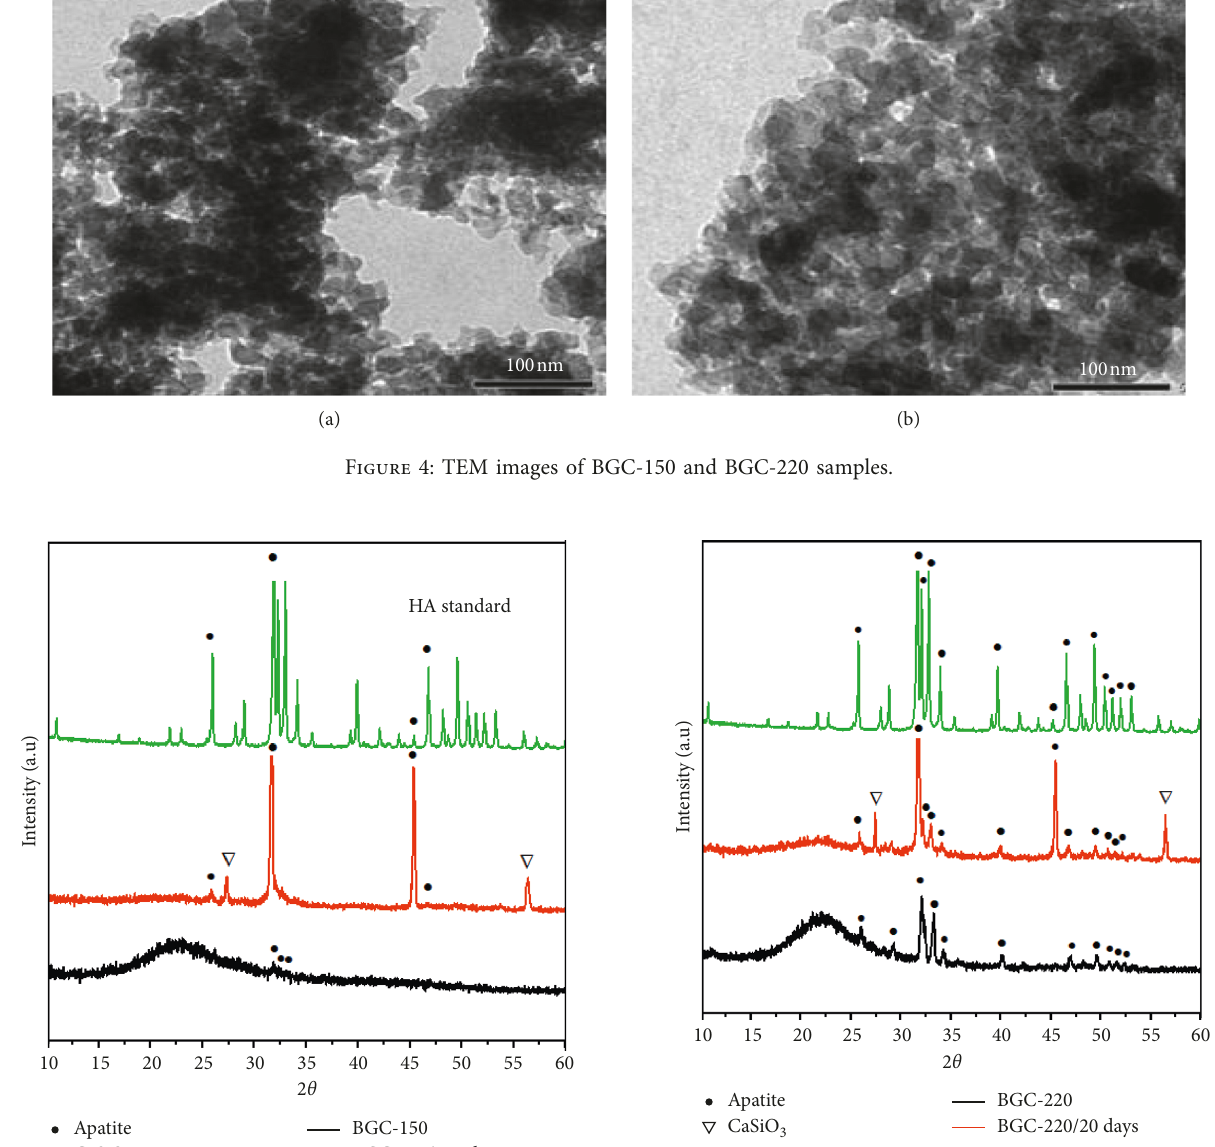
Figure 6: XRD pattern of BGC-220 after 20 days of immersion in SBF